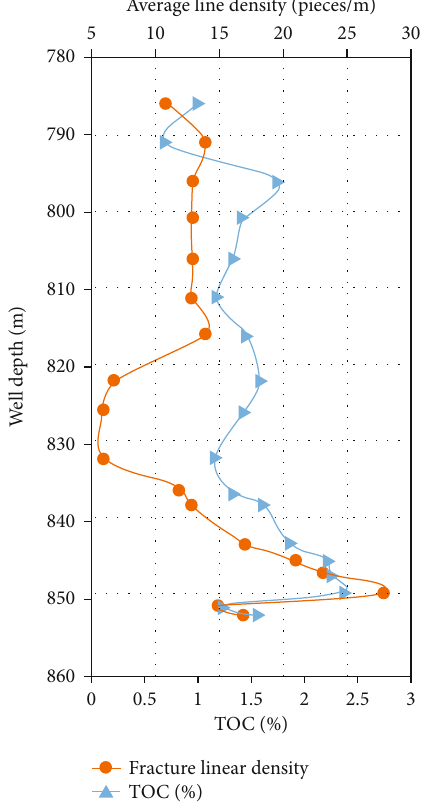
Figure 7: Relationship between TOC and shale fracture development in Well Yucan-7 of the Longmaxi Formation in southeastern Chongqing.